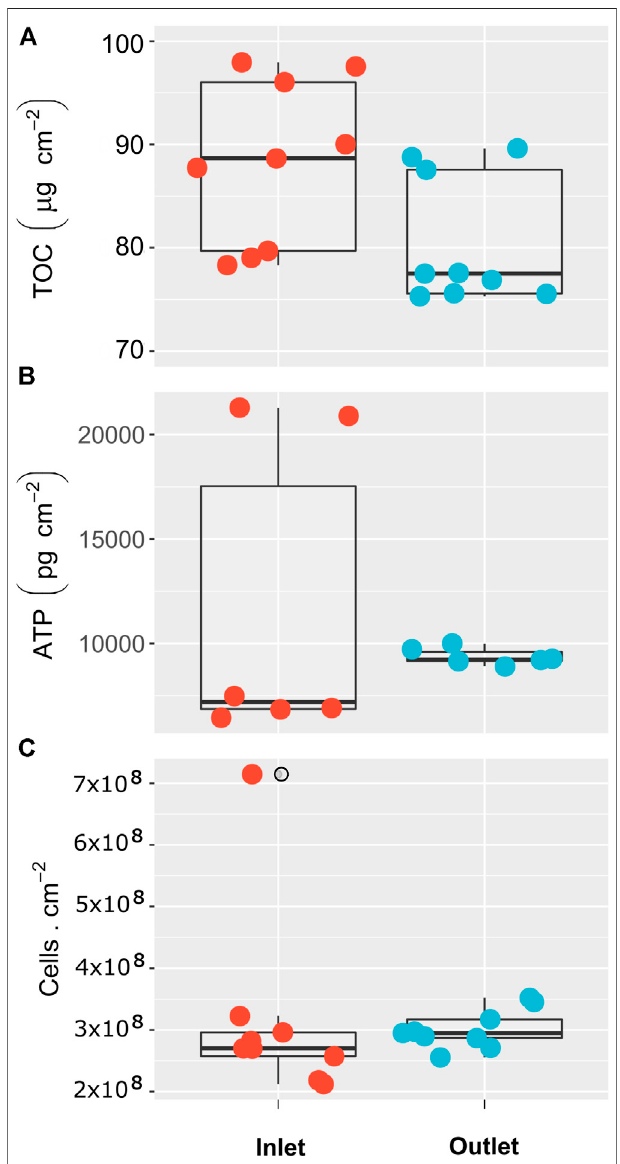
FIGURE 4 | Organic material and biofouling indicators on the inlet and outlet ( fi rst and last 10 cm) sections of the membrane surface. (A) Total organic carbon. (B) Adenosine triphosphate. (C) Cell